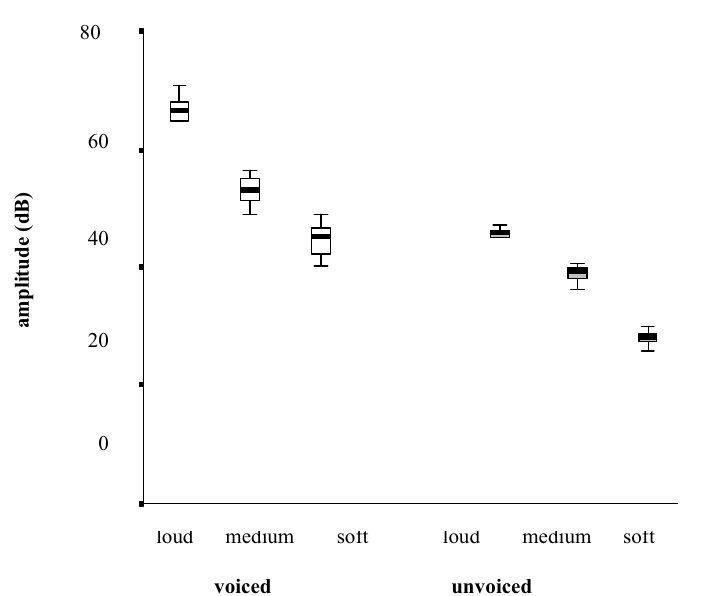
Fig. 3 – Boxplots of amplitude measures ascertained for words (here numbers) spoken either in normally (left) or in a whispered manner (right). Pooled data. Data referred to a total of 400 words recorded from eight subjects (see text).